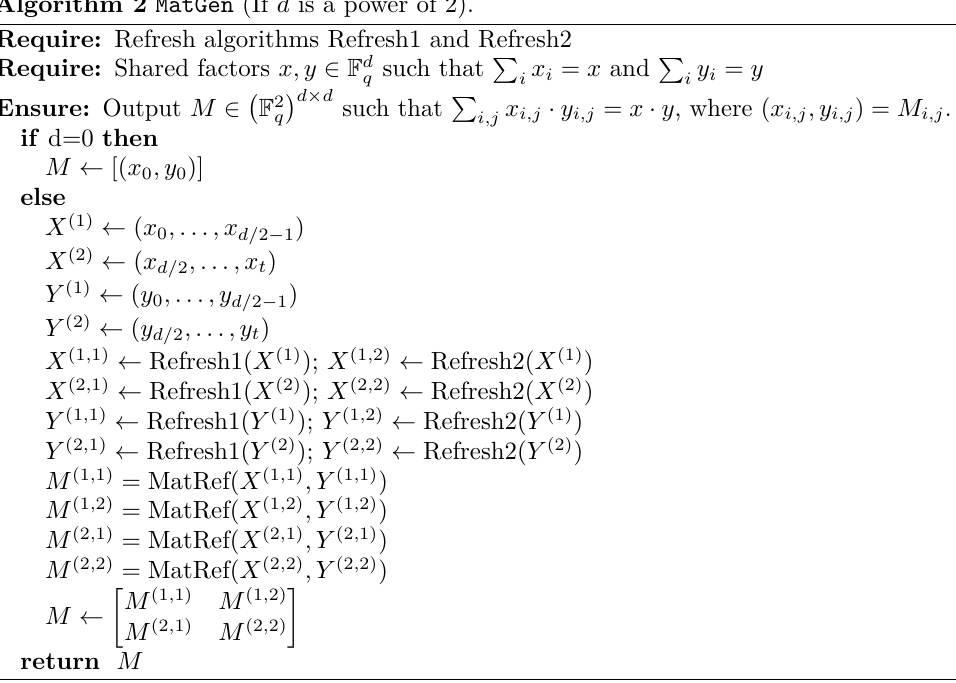
Algorithm 2 MatGen (If d is a power of